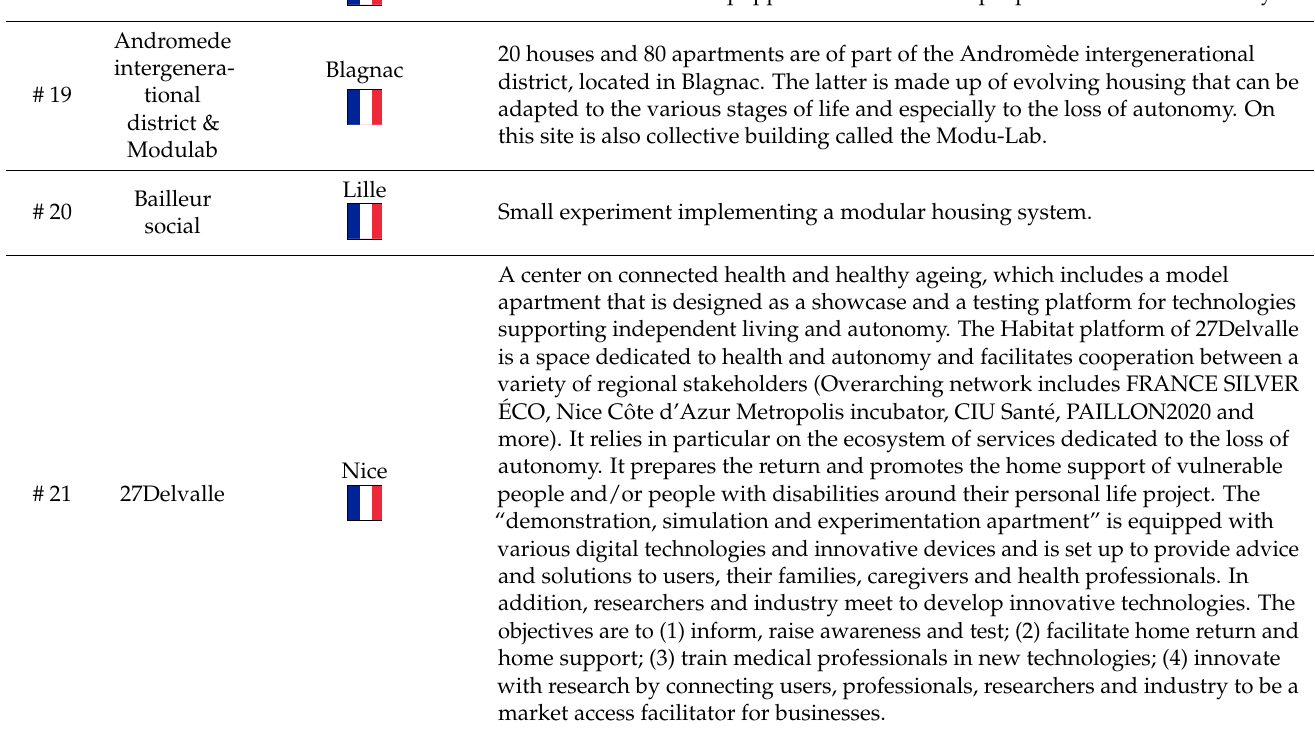
Table 2. Overview of 8 key age-friendly home experiments in the Netherlands, France, Ireland and Poland (see Table A1 in Appendix A for the complete overview of 53